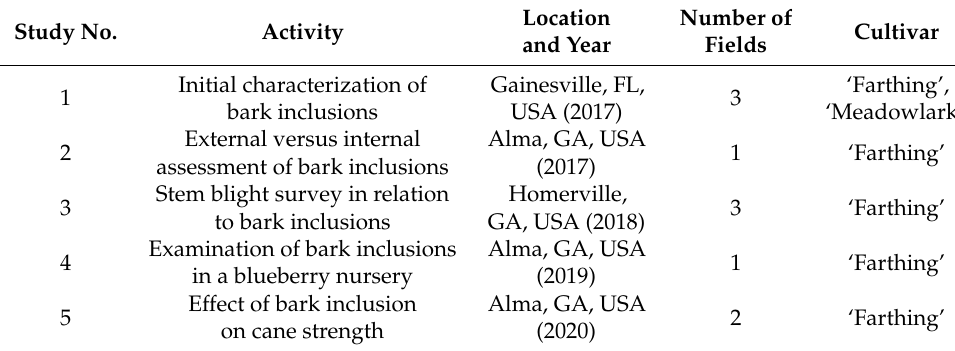
Table 1. Field studies in which bark inclusion at cane junctions of southern highbush blueberry plants were investigated. Study